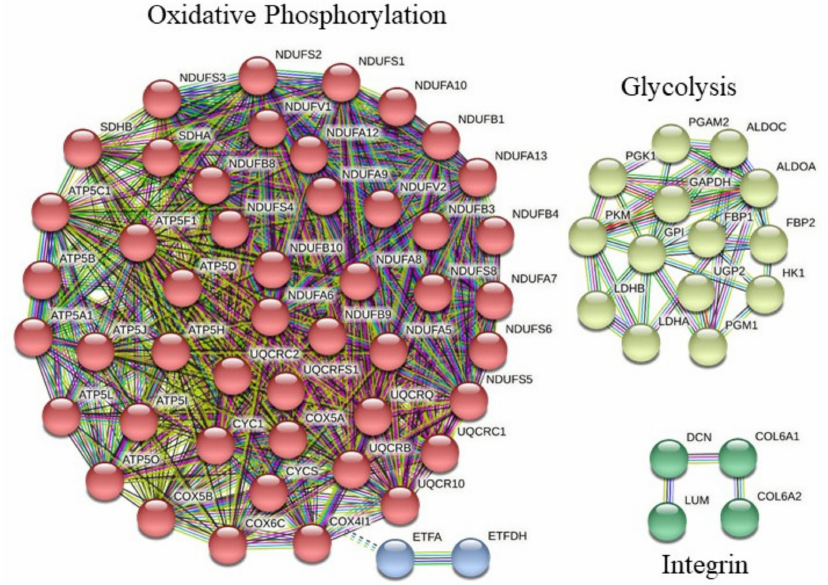
Figure 6. Pathways affected by 24TR in 50Y muscles: protein–protein interaction network. The interaction map was generated using STRING with the highest confidence (0.90), MCL clustering (1.8 inflation parameter), and all criteria for linkage (co-occurrence, co-expression, experiments, neighborhood, databases, text-mining, and